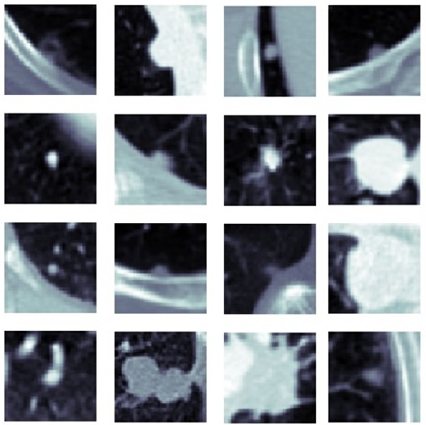
Figure 19. SFMPF model based on Bilateral image—missed nodules (FN).